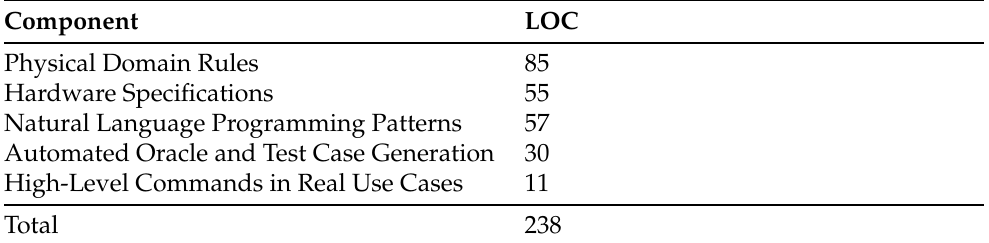
Table 2. Knowledge base code complexity in terms of Lines of Code